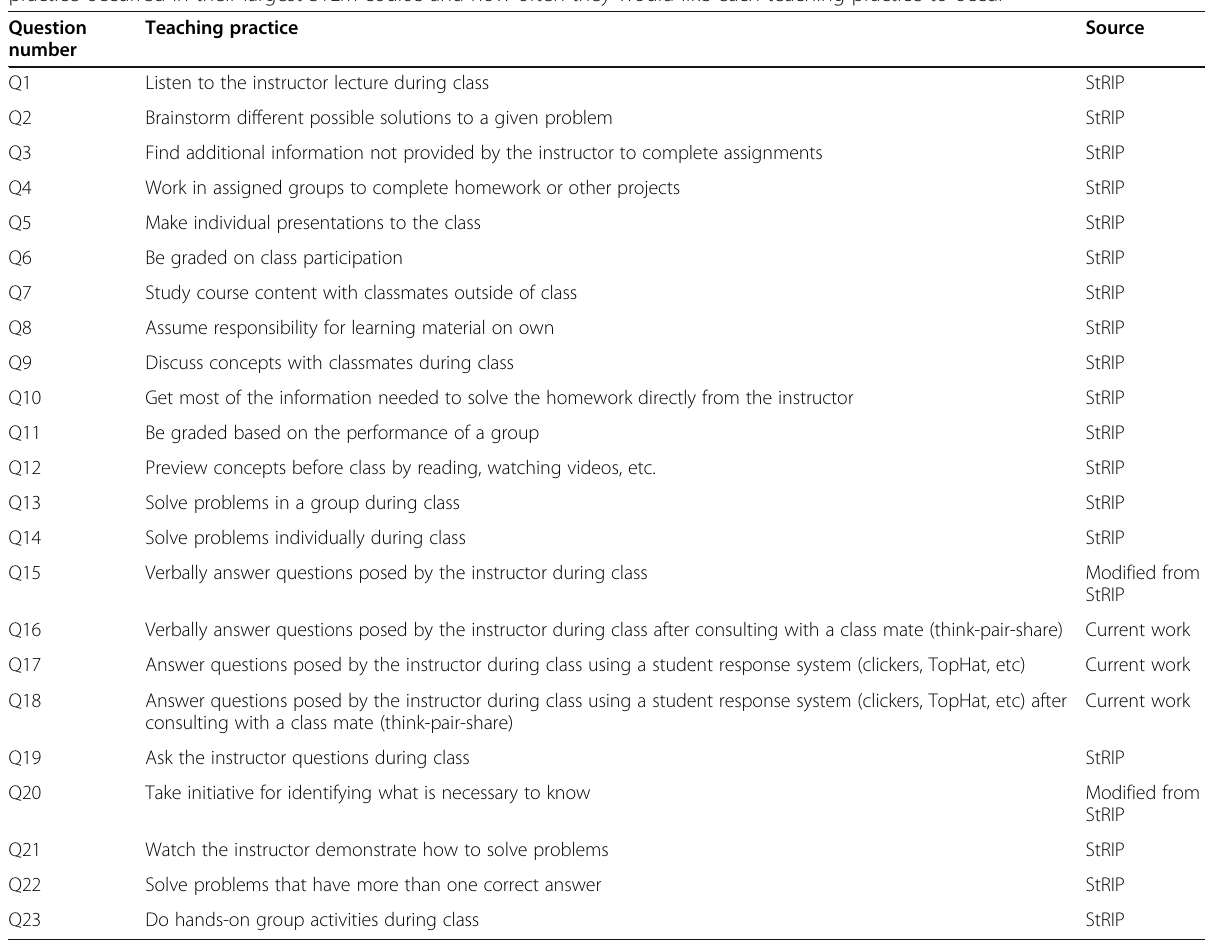
Table 1 Teaching practices included in the survey instrument and their source. Students were asked how often each teaching practice occurred in their largest STEM course and how often they would like each teaching practice to